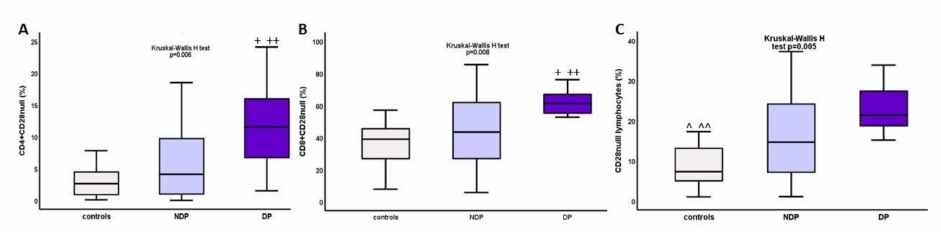
Figure 3. Differences in percentage of ( A ) CD4+CD28null cells, ( B ) CD8+CD28null cells, and ( C ) total CD28null cells between DM, NDM, and controls. * p DM vs. controls <0.0001, ** p DM vs. NDM <0.04, ˆ p NDM vs. controls 0.04, ˆˆ p DM vs. controls <0.0001.